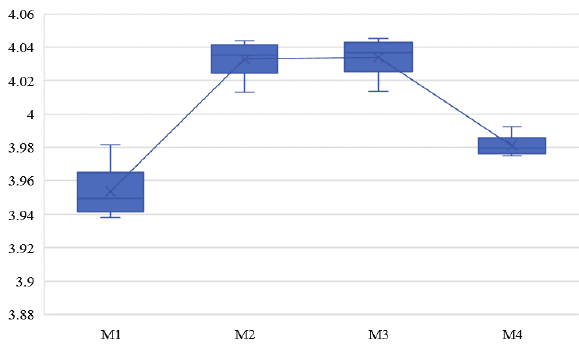
Figure 5. Eff ect of changing D p value in the ranking